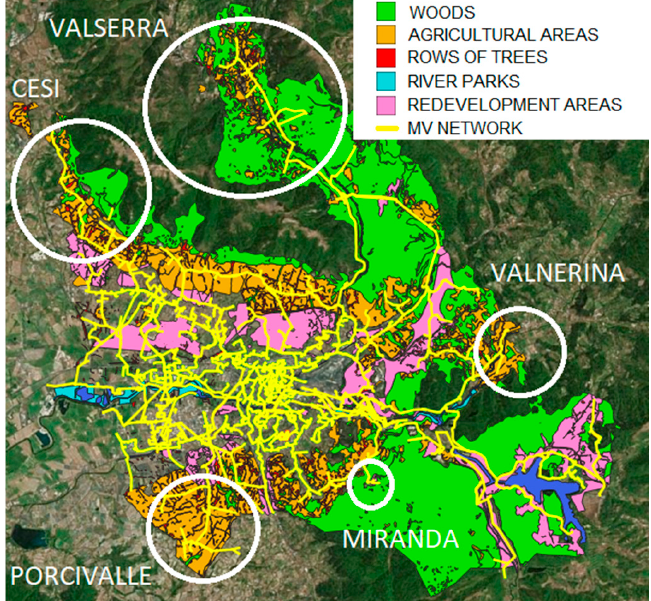
Figure 3. Subareas in Terni municipality according to tree fall threat.